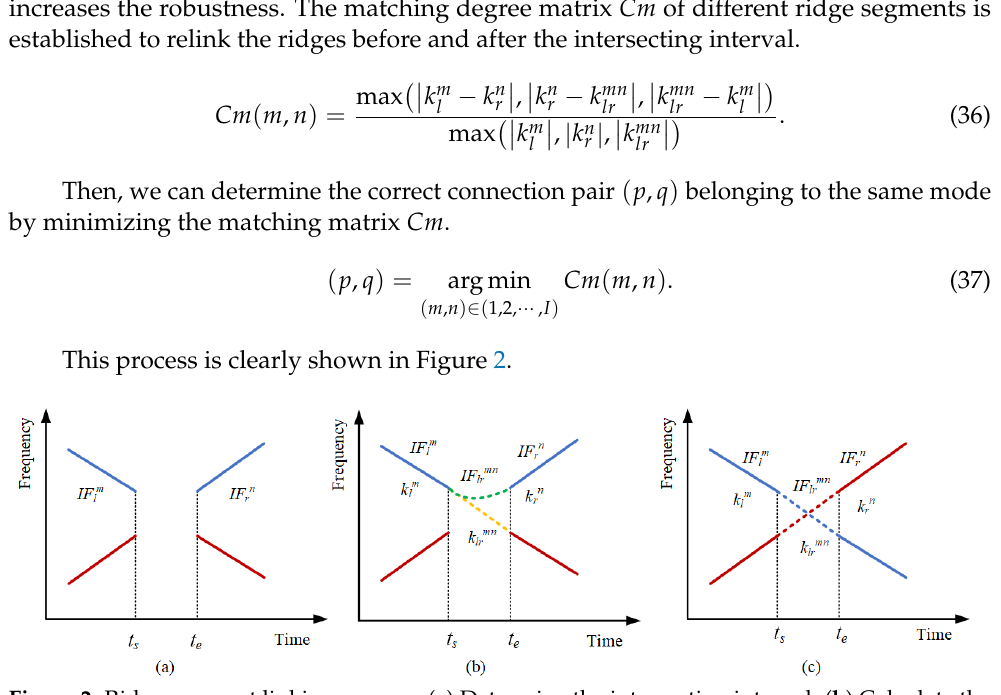
Figure 2. Ridge-segment linking process. ( a ) Determine the intersection interval. ( b ) Calculate the rate of change of the ridges. ( c ) Ridge-segment